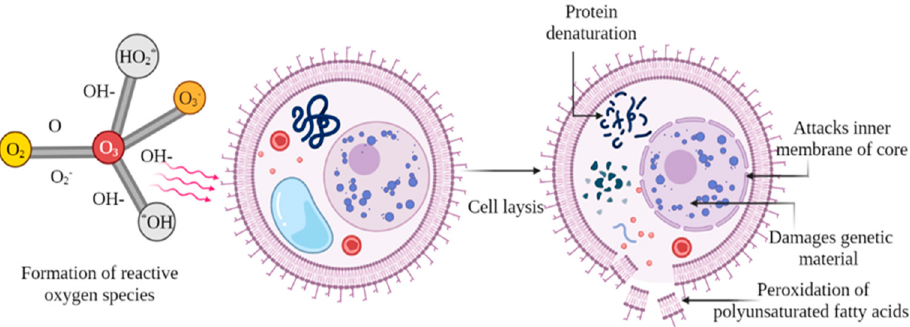
Figure 1. Schematic presentation of decontamination using ozone.